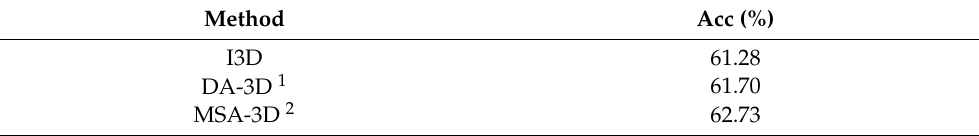
Table 3. Accuracy of derivative models with RGB data.